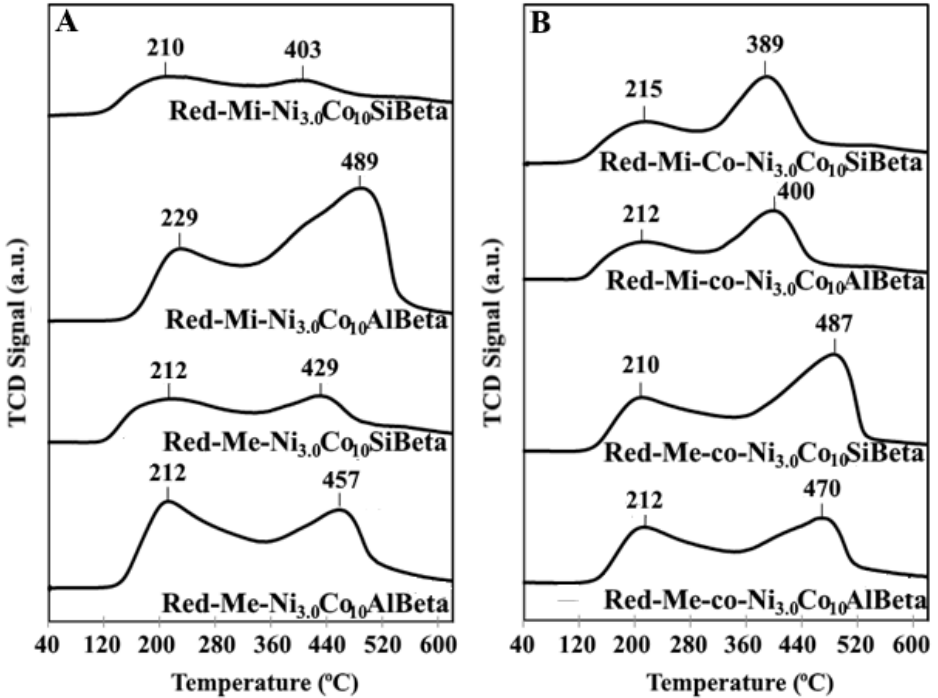
Figure 5. NH 3 -TPD profiles of ( A ) Red-Me-Ni 3.0 Co 10 Beta, Red-Mi-Ni 3.0 Co 10 Beta and ( B ) Red-Me-co-Ni 3.0 Co 10 Beta, Red-Mi-co-Ni 3.0 Co 10 Beta.